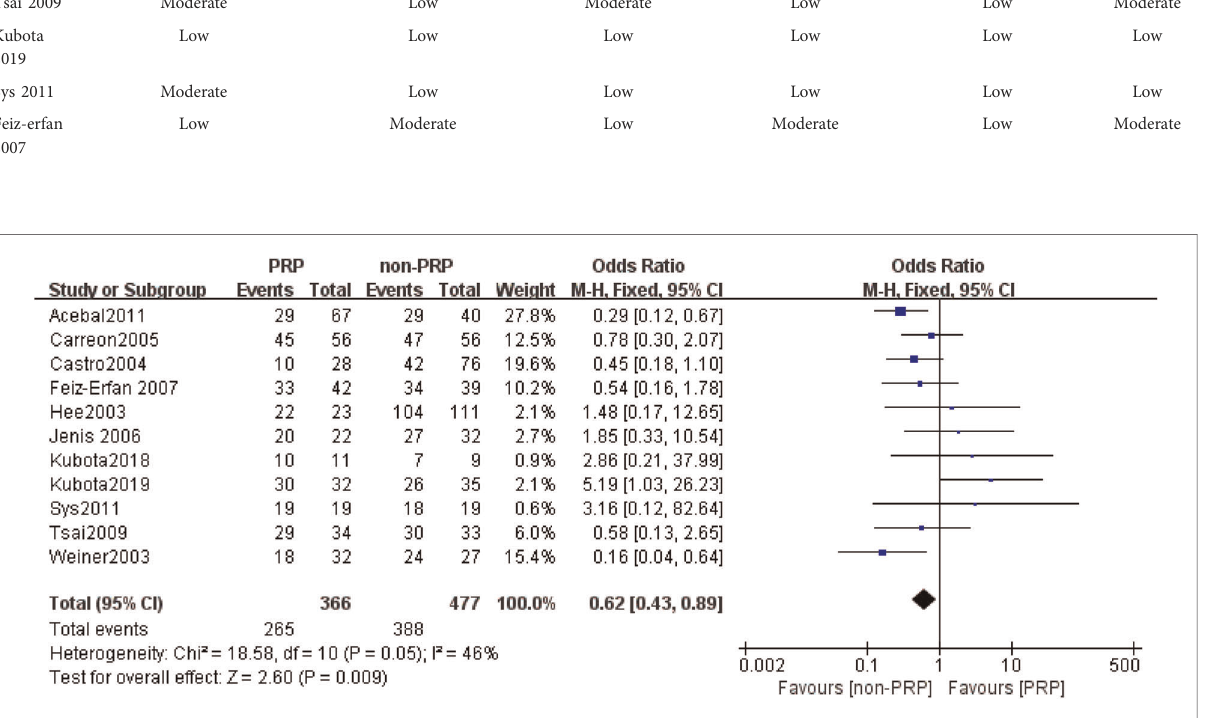
FIGURE 2 Forest plot of the fi nal fusion rate (at least >2 years).